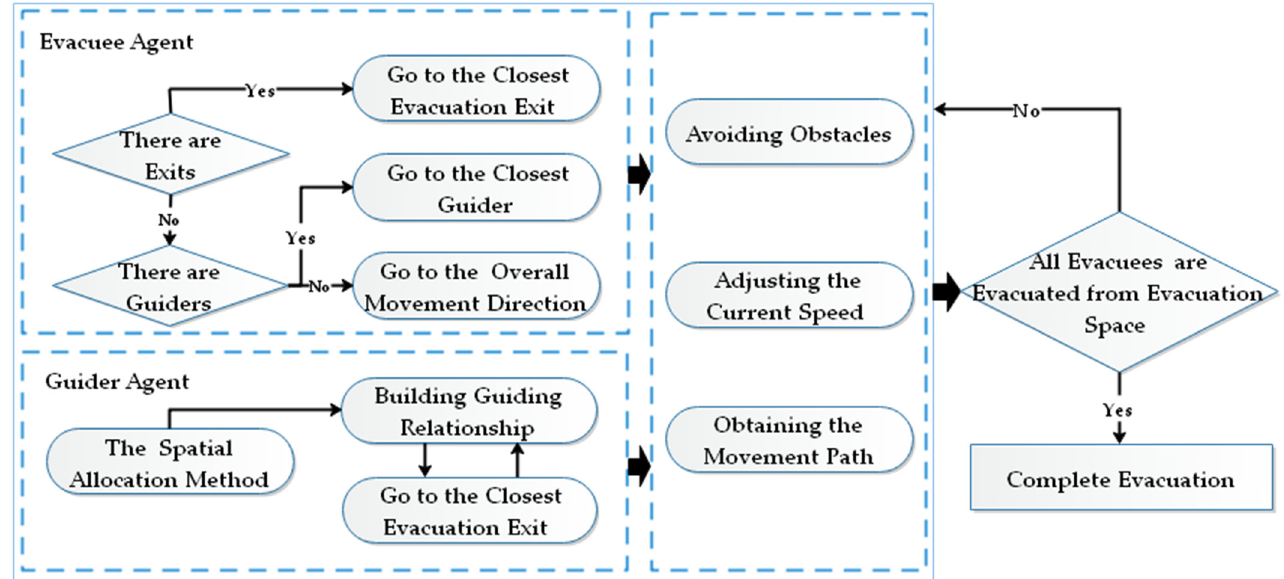
Figure 5. Flow chart of the evacuation behaviors of the agents (the evacuation guiders and evacuees).